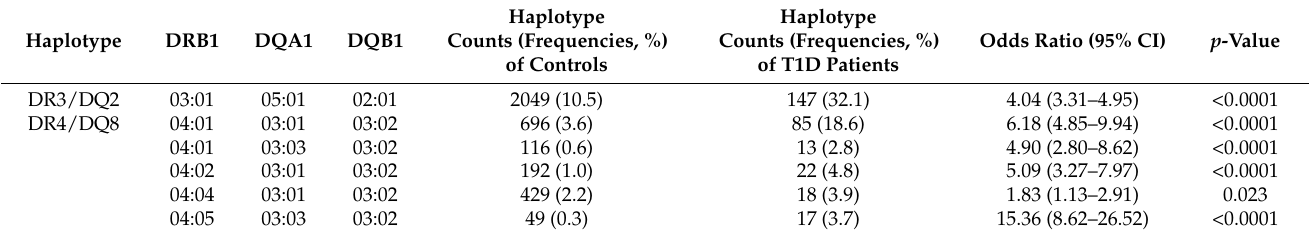
Table 3. DRB1–DQA1–DQB1 haplotype counts and frequencies in controls and type 1 diabetes patients.